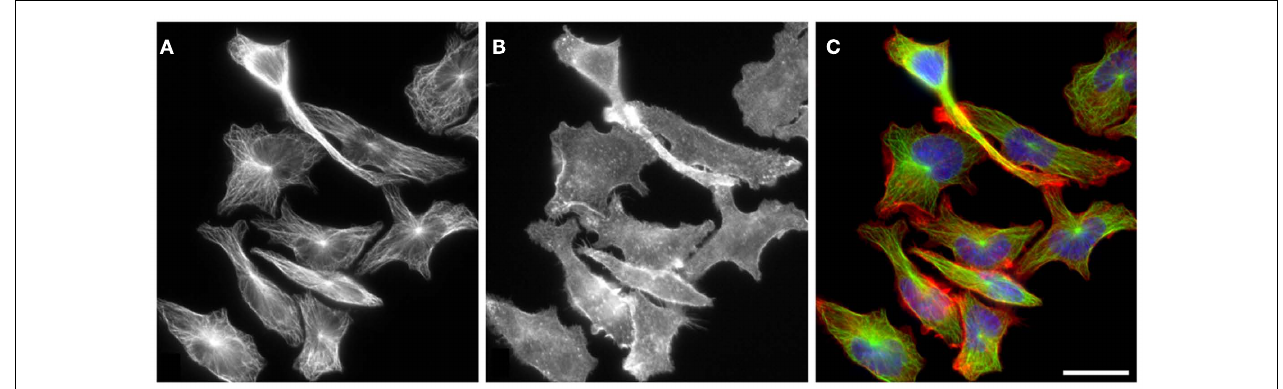
with formaldehyde and extracted withTriton X-100 before staining with rabbit antibody to α -tubulin [ (A) ; green] and rhodamine-conjugated phalloidin [ (B) ; red]. DNA was stained with DAPI (blue). Superposition of α -tubulin and F-actin is shown in (C) . Scale bar, 20 μ m. Photography E. Dráberová (Institute of Molecular Genetics AS CR,